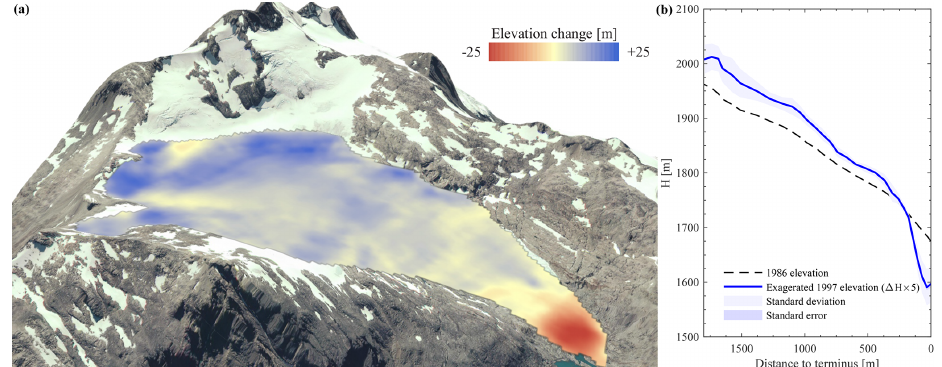
Figure 15. (a) Map of change in elevation between interpolated GPS transects captured in January 1997 (Willis et al., 2009) and 15m DEM from large-scale national topographic mapping based on imagery dated February 1986 (Columbus et al., 2011). (b) Change in profile between 1986 and 1997 ( (cid:49) H are exaggerated 5 times).